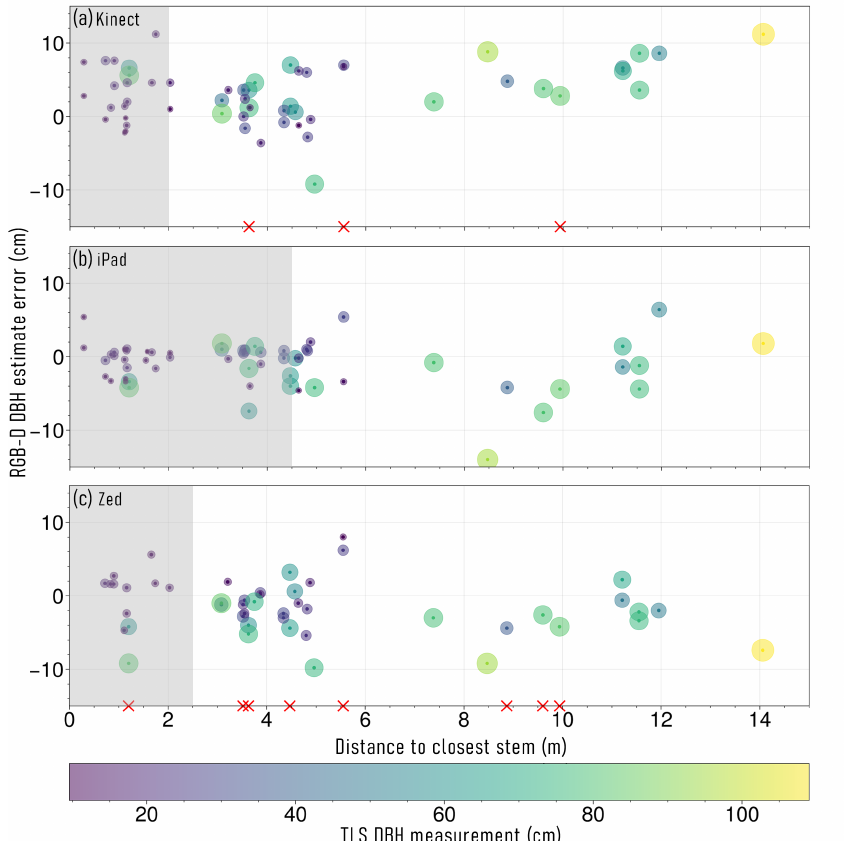
Figure 5. Stem diameter at breast height (DBH) measurement error (cm) derived from colour and depth (RGB-D) sensors, and the distance from target stem to the next closest stem. ( a ) Microsoft Azure Kinect, ( b ) Apple iPad Pro 2020, and ( c ) Stereolabs Zed 2. The symbol size and colour around points represents the DBH of each stem measured with terrestrial laser scanning (TLS). The red × symbols on the x -axis represent trees that were unable to be captured using the respective RGB-D sensor and the distance to the next closest stem within their plot. The grey shaded section on each plot represents the range in which duplicate stems could occur for each RGB-D